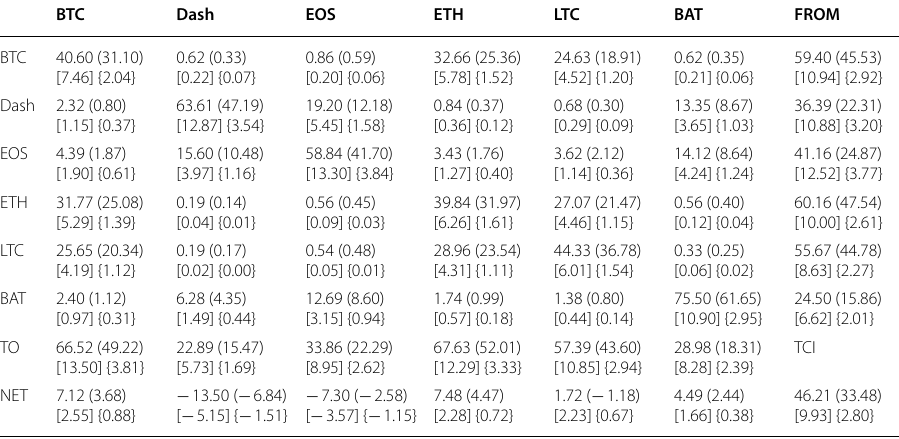
Table 10 Averaged connectedness